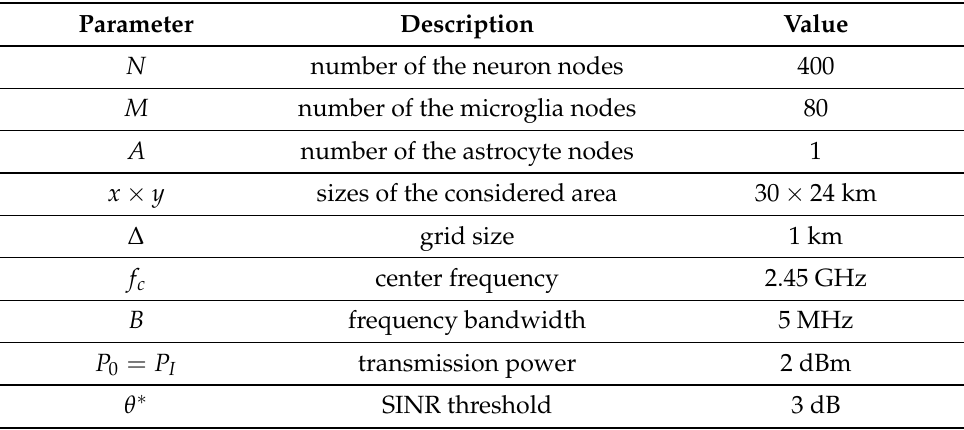
Table 2. Simulation parameters used in the second phase of the